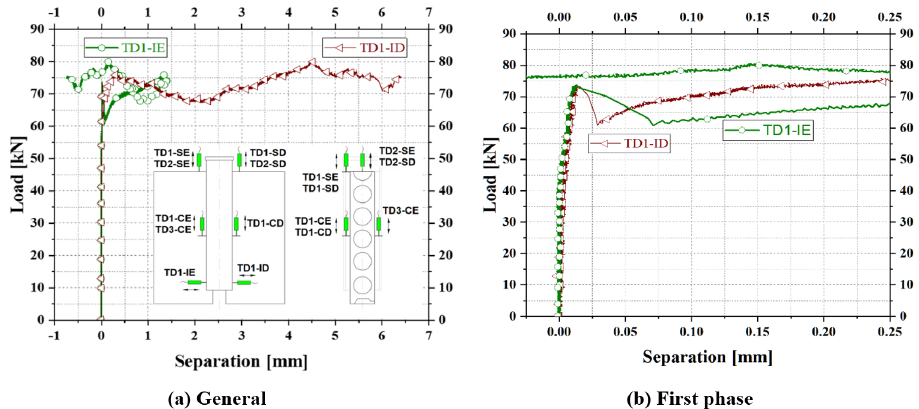
Fig. 12: Horizontal separation between the steel profile and precast slab at the bottom of specimen